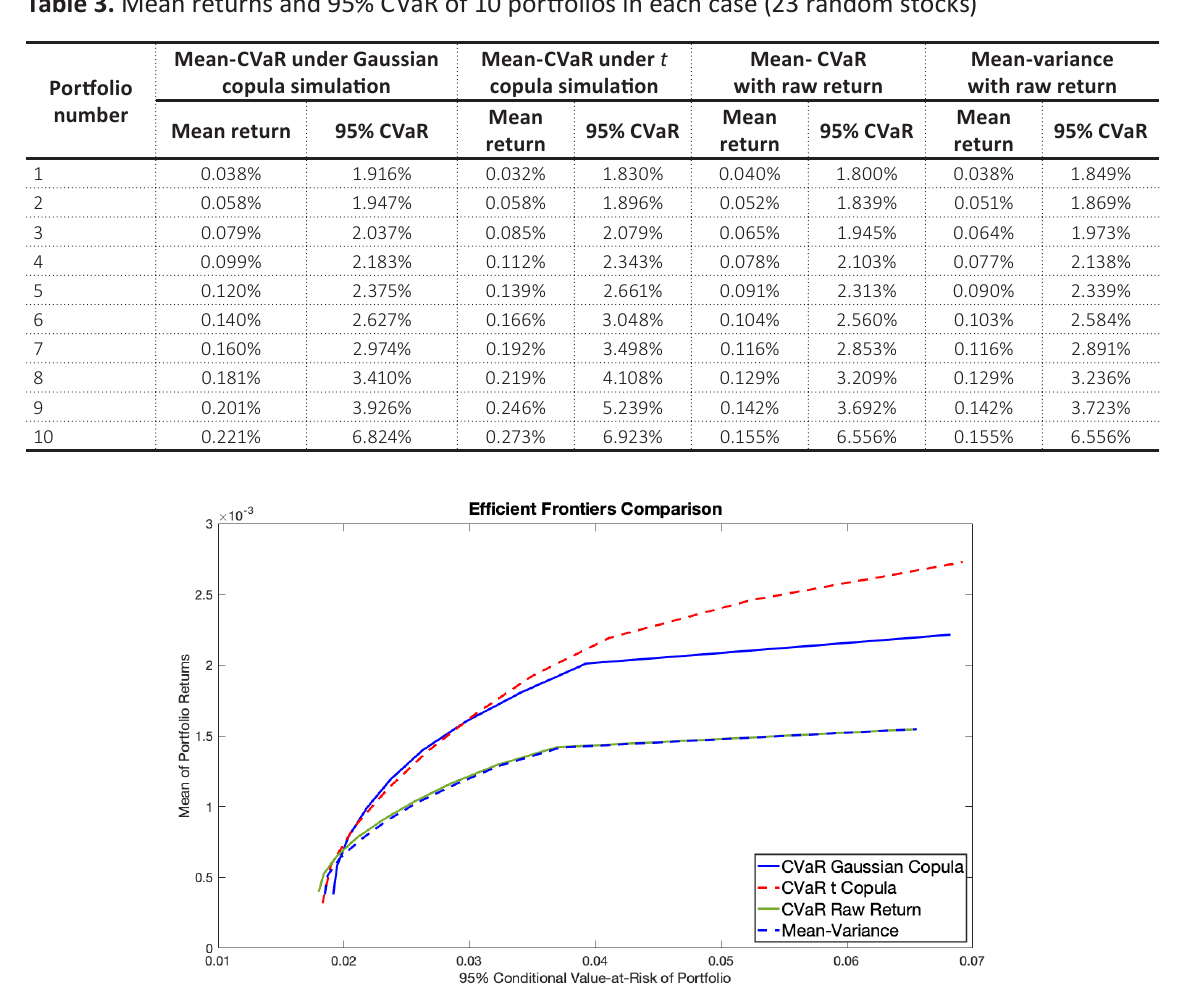
Figure 3. Mean-CVaR efficient frontiers with 95% CVaR (23 random